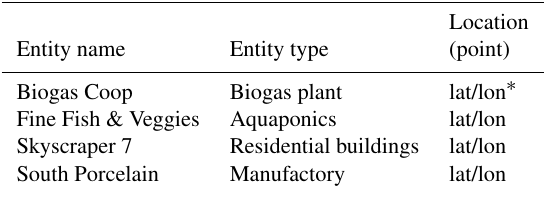
Table 1. Hypothetical Circular Economy Entities.